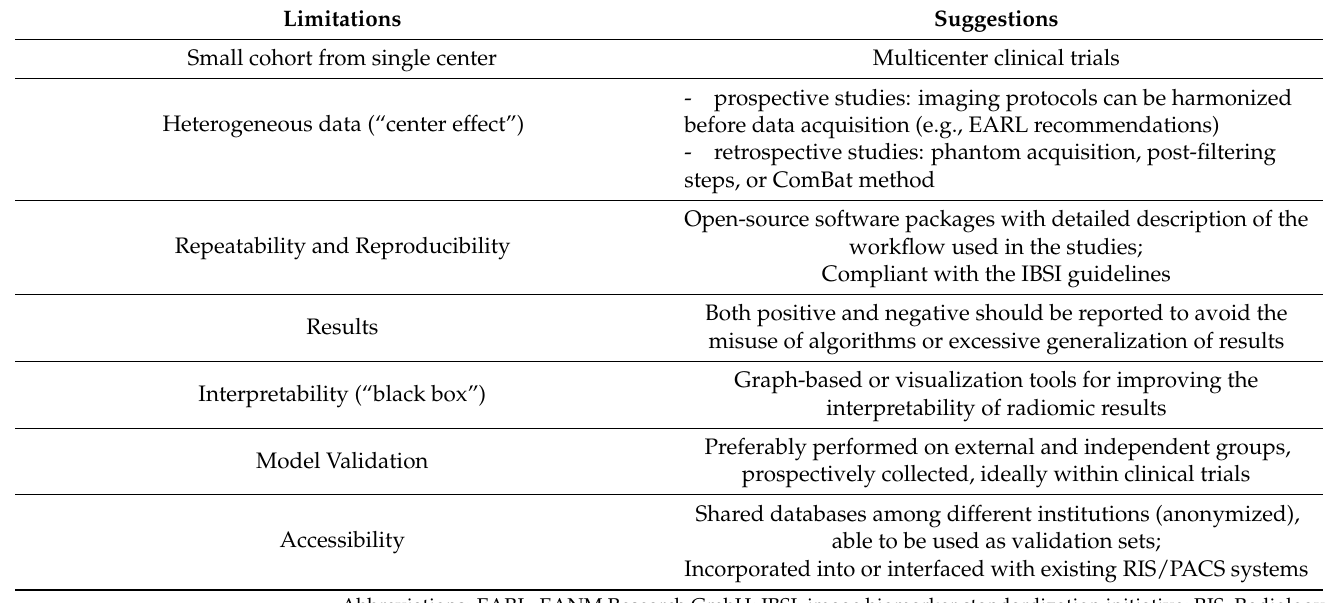
Table 4. Summary of main issues and possible solutions for radiomic